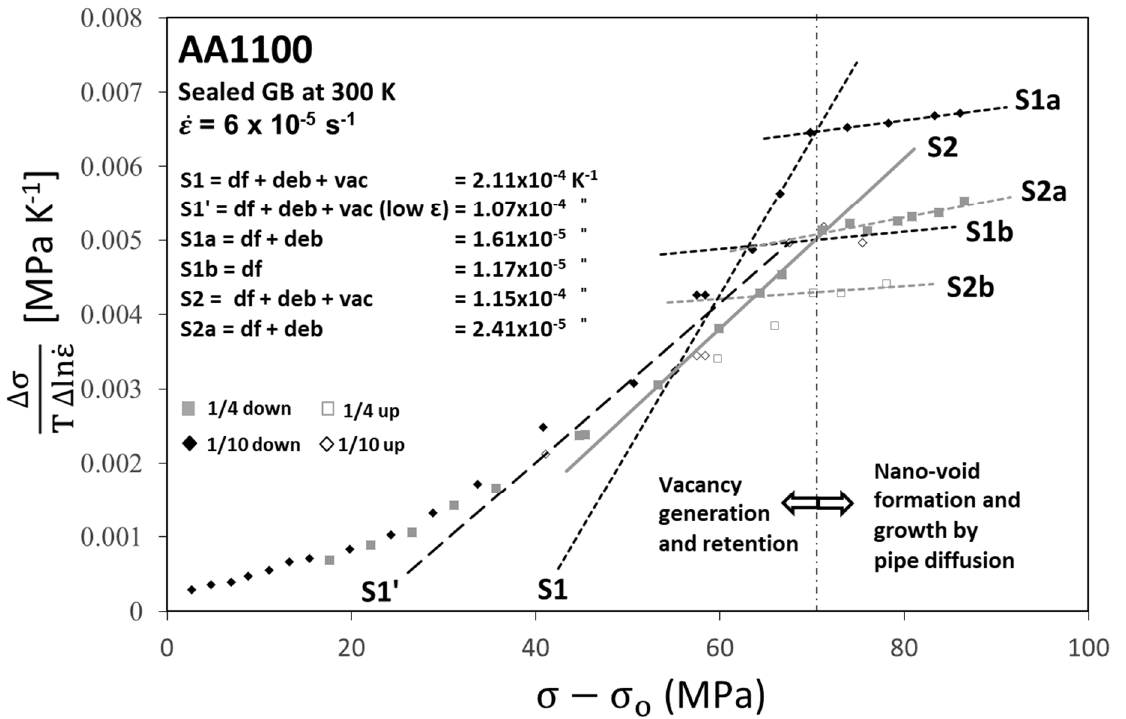
Figure 9. Comparison of the Haasen plots at 300 K with lines drawn through the linear ranges. Unlike the up-change data points the down-ones tend to curve upwards till it abruptly becomes nearly horizontal indicating the formation of nano-voids to act as vacancy sinks. The text “df” stands for dislocation-forest intersection.